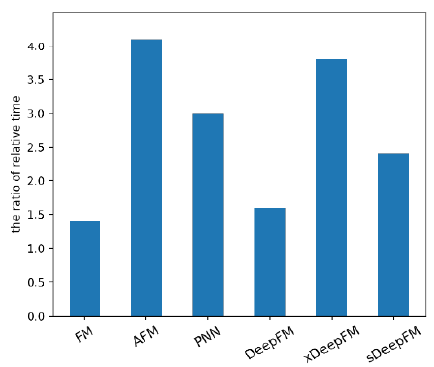
Figure 7. The run time efficiency of the models.